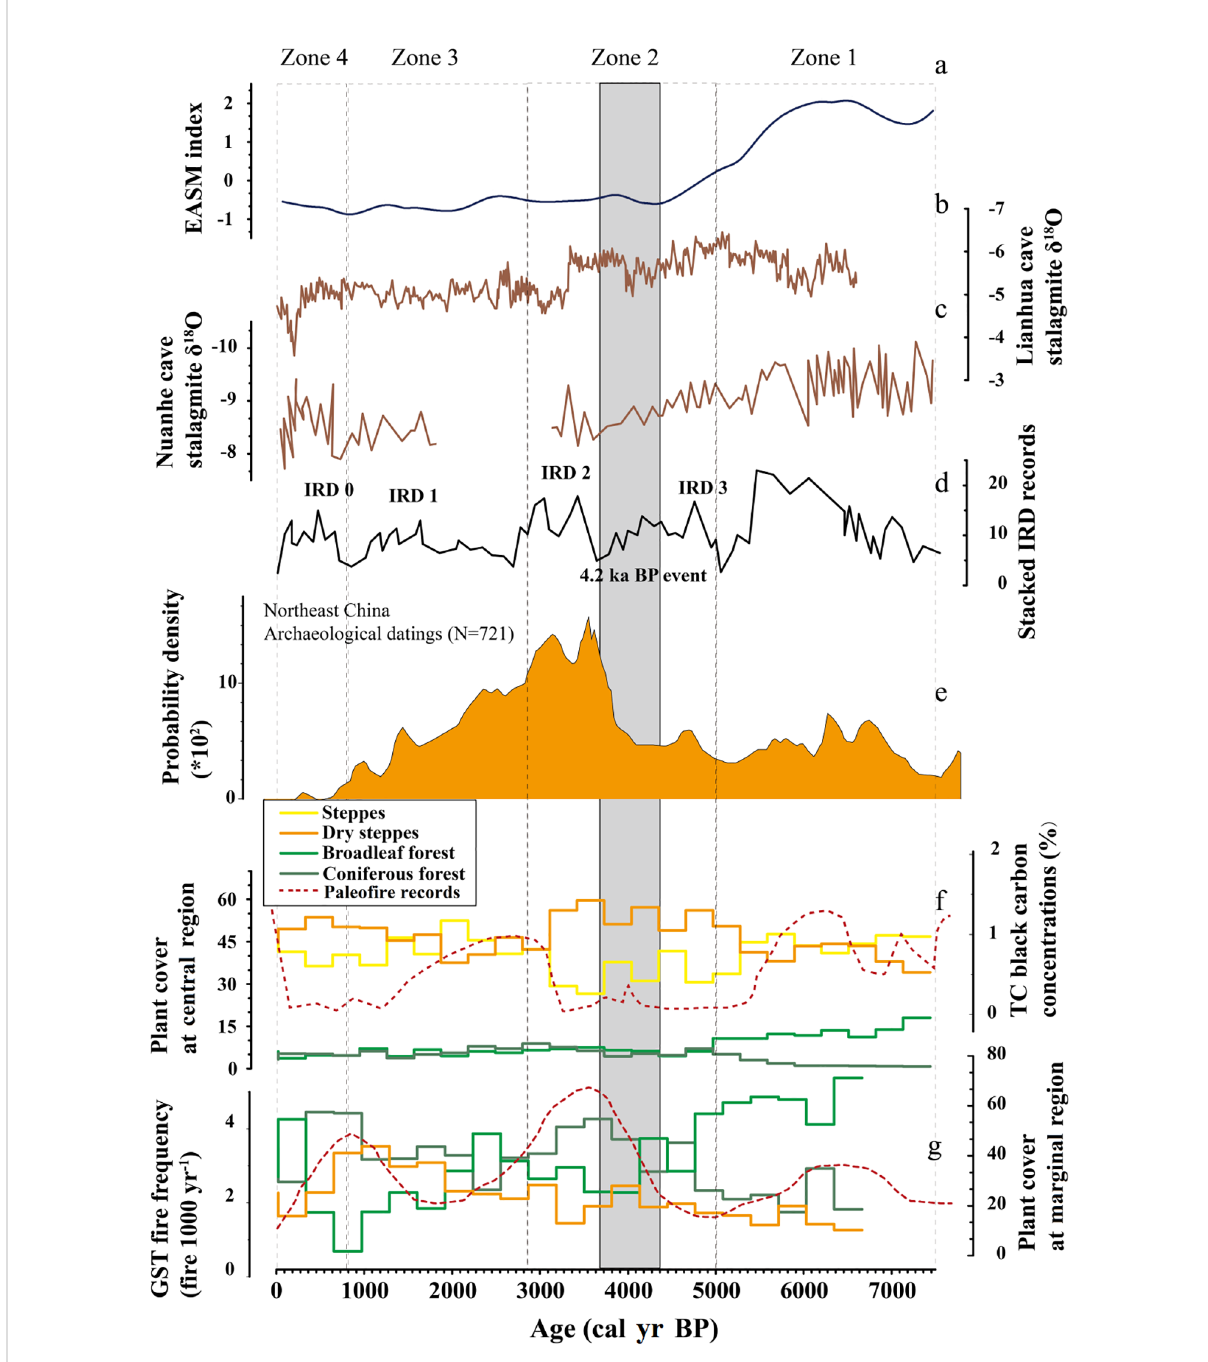
FIGURE 6 Comparisons of regional climate, fi re and human activity records with Songnen grasslands vegetation changes since the mid-Holocene. (A) The EASM index is referenced from a published paper (Chen et al., 2008); (B) The stalagmite d 18 O records are from Lianhua Cave, northern China (Cosford et al., 2009); (C) The stalagmite d 18 O records are from Nuanhe Cave, northeastern China (Wu et al., 2011); (D) Holocene stacked IRD events in the North Atlantic (Bond et al., 2001); (E) Human activity records in northeastern China (Wang et al., 2020); (F) The REVEALS vegetation cover based on pollen records from central region, this study with black carbon records (Peng et al., 2021); (G) The REVEALS vegetation cover based on pollen records from marginal region, this study with fi re frequency records (Meng et al.,